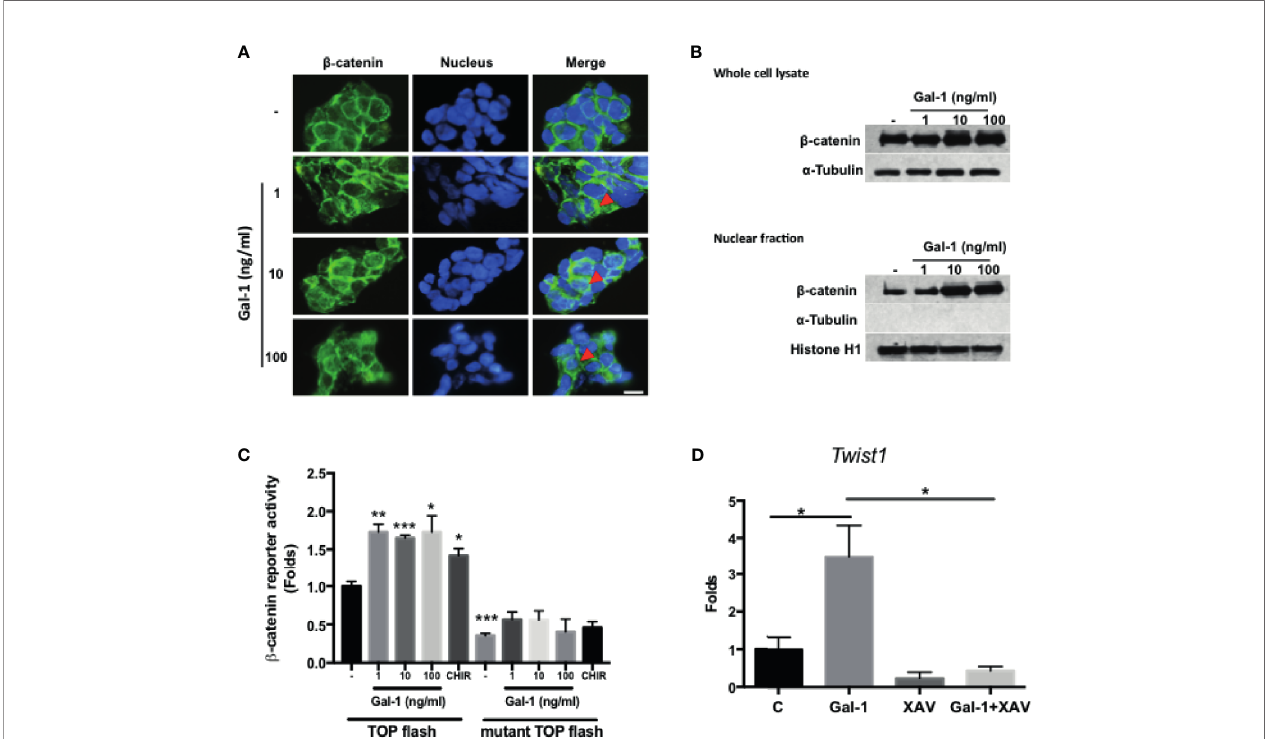
FIGURE 4 | Gal-1 promotes b -catenin expression, nuclear translocation, and activity in CRC cells. (A) IF staining for b -catenin (green fl uorescence) in KM12C with the addition of increasing doses of rhGal-1 for 48 hours. Nuclei were stained with Hoechst 33342 (blue fl uorescence). Arrows show nuclear b -catenin; scale bar, 10 m m. (B) Western blot for b -catenin levels in whole cell lysate (top panel) and nuclear fraction (bottom panel) of KM12C with the addition of increasing doses of rhGal- 1 for 48 hours; for nuclear fraction, histone H1 is used as the positive control and a -Tubulin as the negative control. (C) Luciferase reporter assay for b -catenin activity in KM12C with the addition of increasing doses of rhGal-1. TOPFlash plasmids ( b -catenin promoter reporter construct containing TCF/LEF binding sites; please see Materials and Methods) and TOPFlash mutant plasmids ( b -catenin promoter reporter construct containing mutated TCF/LEF binding sites; please see Materials and Methods) were transduced into KM12C, with the luciferase activity measured 48 hours later; addition of the Wnt/ b -catenin agonist CHIR-99021 (CHIR; 0.3 µM) was used as a positive control. (D) qPCR analysis for the gene expression of Twist1 in KM12C after treatment with rhGal-1 (100 ng/ml) and without or with the Wnt/ b -catenin antagonist XAV-939 (XAV; 10 µM) for 24 hours. All results are shown as the mean ± SEM ofthree independentexperiments. * p < 0.05; ** p < 0.01, and *** p < 0.005 compared to the